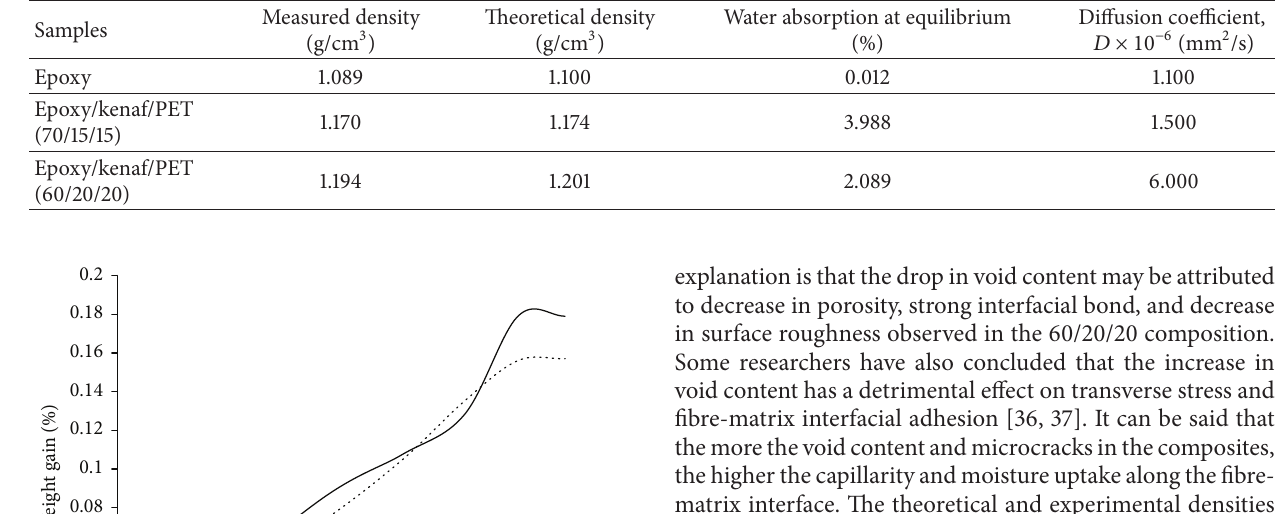
Table 2: Diffusion properties and densities of the hybrid composites.